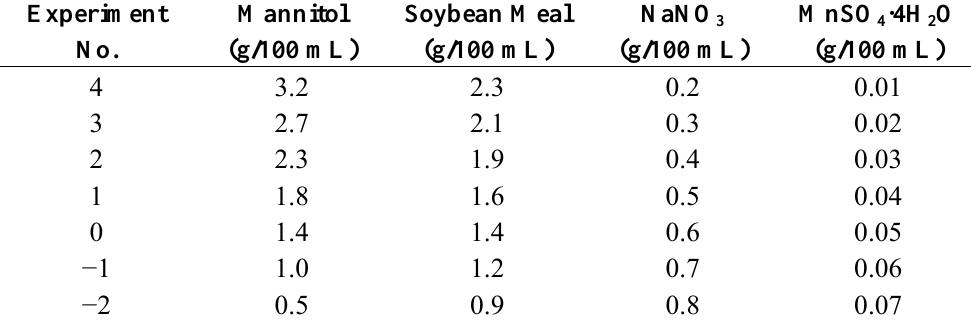
Table 4. Experimental design of steepest ascent and corresponding responses ( n = 3).